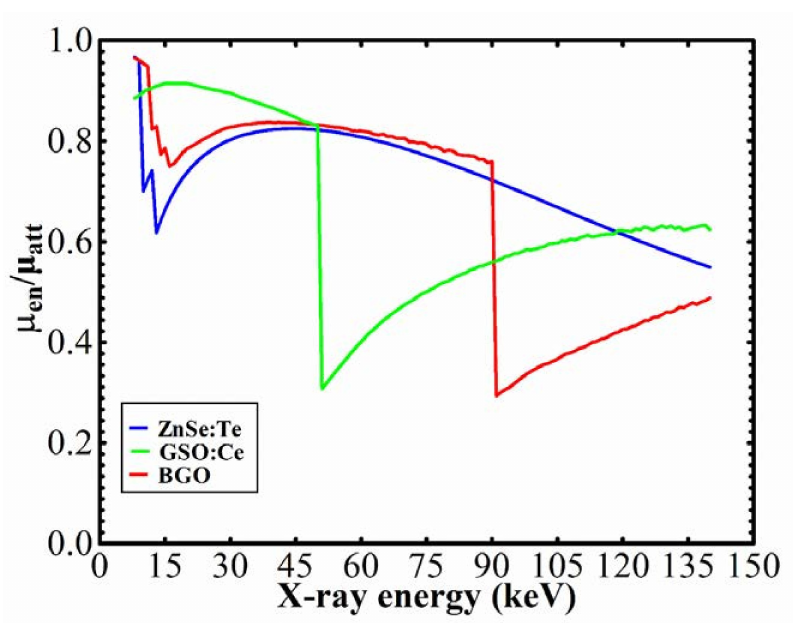
Figure 3. Attenuation coe ffi cients ratio µ en / µ att of ZnSe:Te, BGO and GSO: